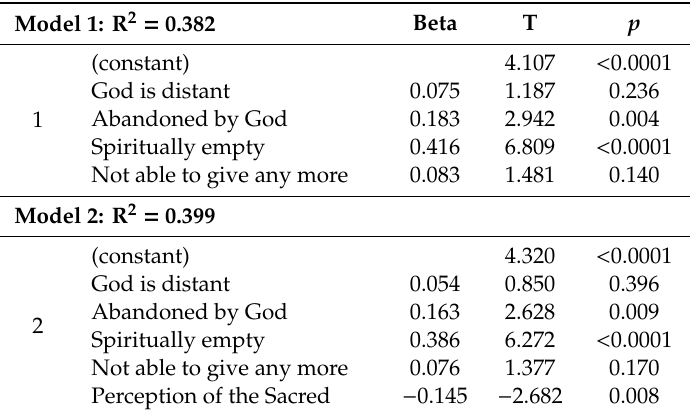
Table 3. Regression analyses among